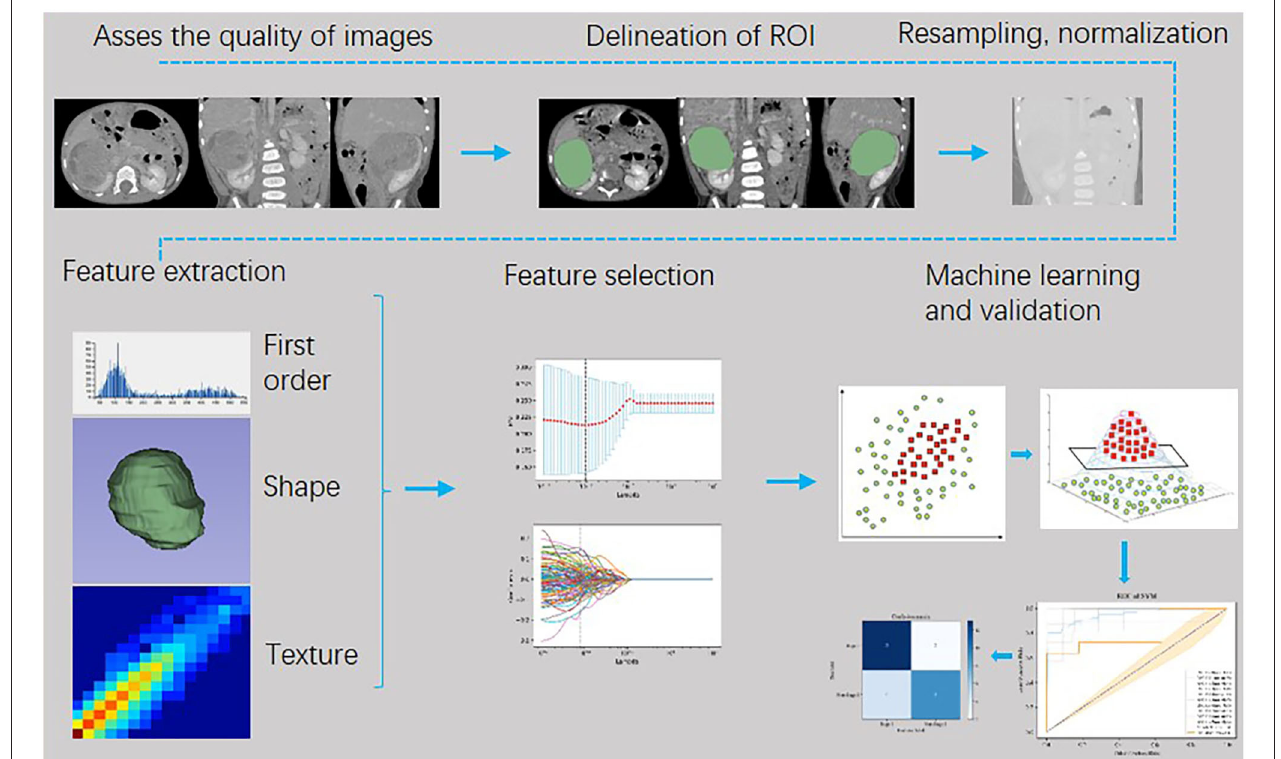
FIGURE 1 | Flowchart of Wilm’s tumor (WT) staging based on machine learning model of